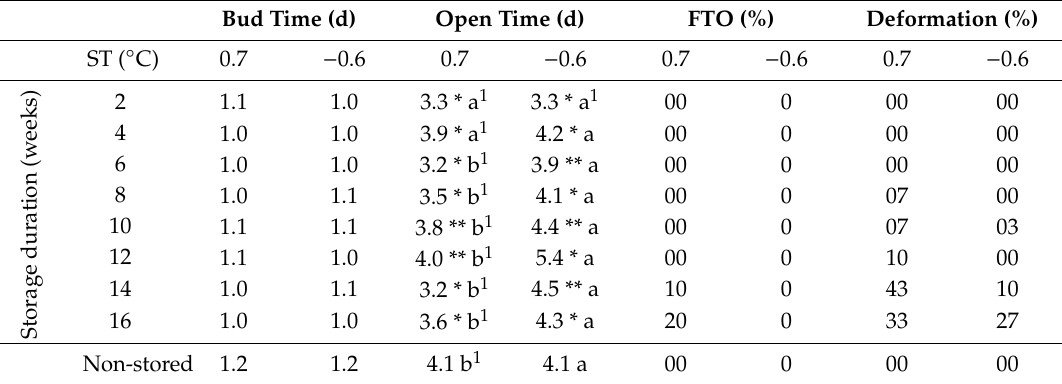
Table 2. Exp2 bud time (d), flower open time (d), percentage of flowers that failed to open, and percentage of deformed flowers for Paeonia lactiflora cultivar Monsieur Jules Elie (MJE) in response to storage temperature (ST) and storage duration. Bud Time (d) Open Time (d) FTO